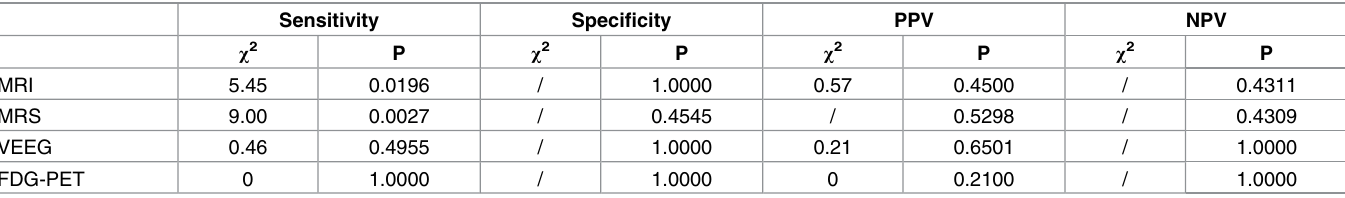
Table 3. Comparison of RS-fMRI with other EZ localization techniques. Sensitivity